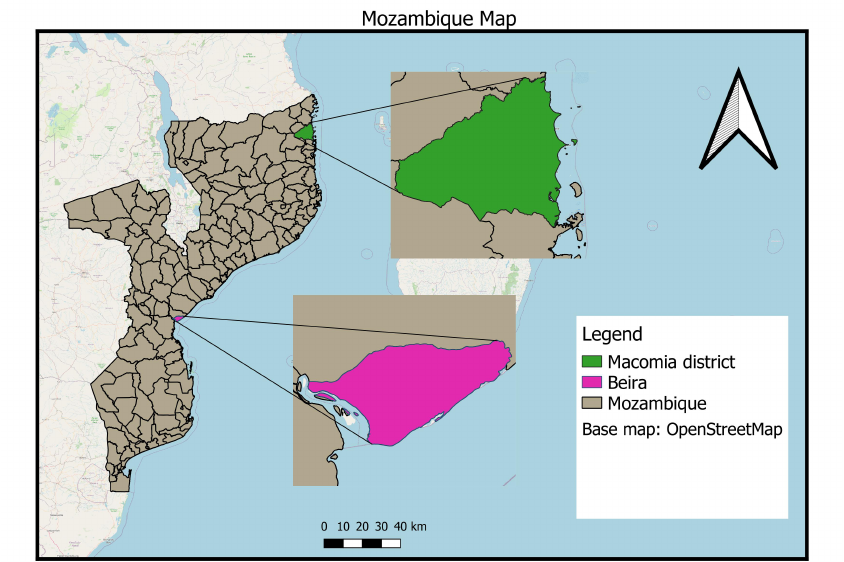
Figure 1. Mozambican map with the city of Beira and the Mocomia district highlighted. The base map is the open street map obtained from Qgis plugins.